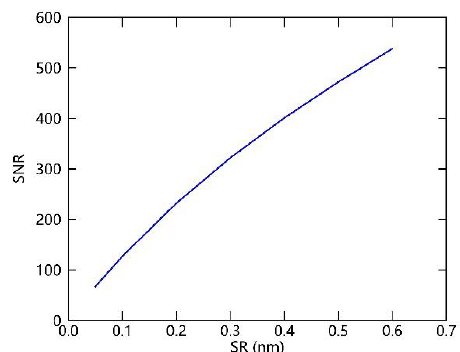
Figure 3. Curve of signal-to-noise ratio (SNR) versus spectral resolution (SR) provided by the instrument manufacturer.